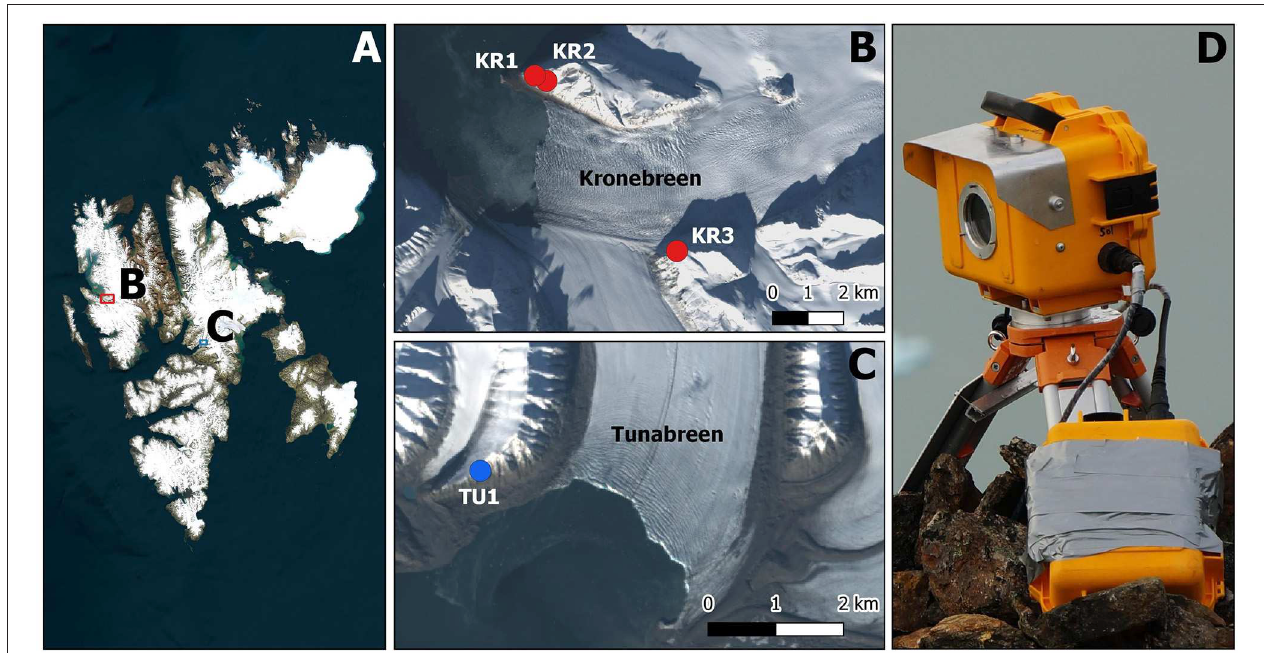
FIGURE 2 | Maps showing the Svalbard archipelago (A) , Kronebreen (B) , and Tunabreen (C) with numbered camera sites installed over the 2014 and 2015 melt seasons; and an example of one of the time-lapse camera installations in the field (D)